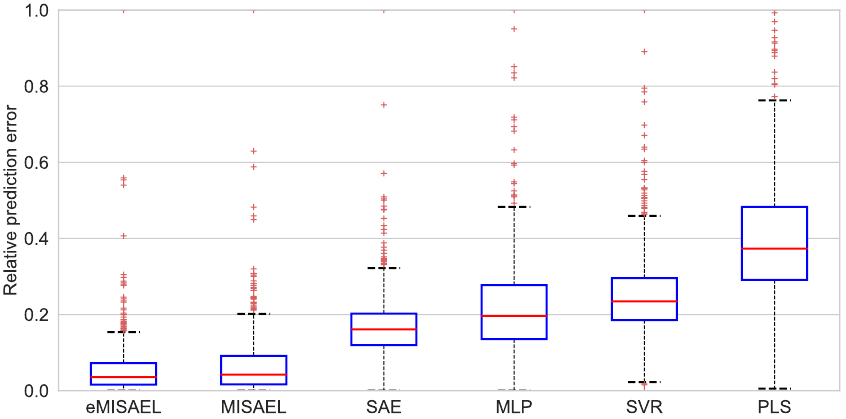
Figure 13. Relative prediction error of testing results for SRU process using eMISAEL, MISAEL, SAE, MLP, SVR, and PLS models,